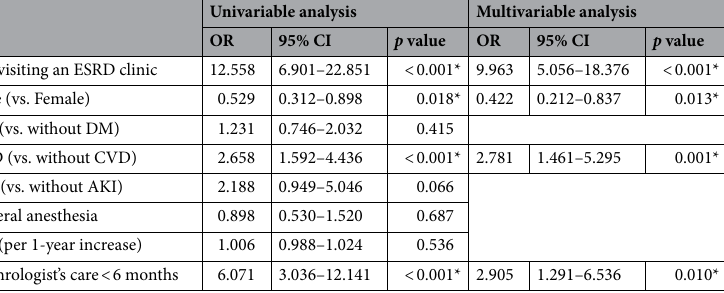
Table 3. Analysis of the relationship between not visiting an ESRD clinic and emergent initiation of dialysis (B in Fig. 3). OR, odds ratio. * p value < 0.05.